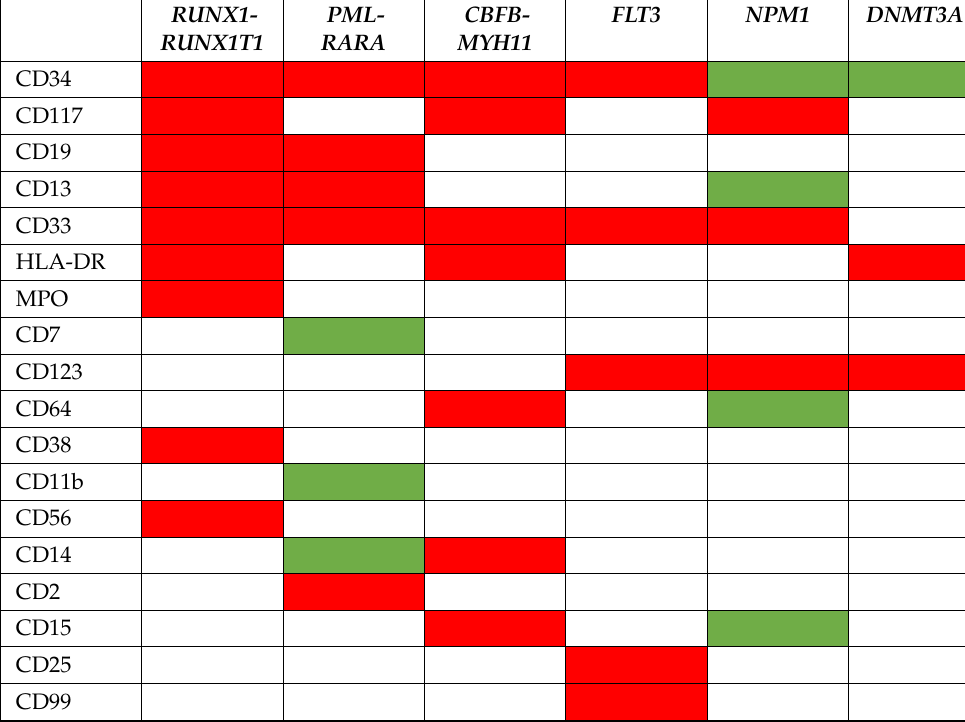
Table 2. Correlation between mutations and immunophenotypic